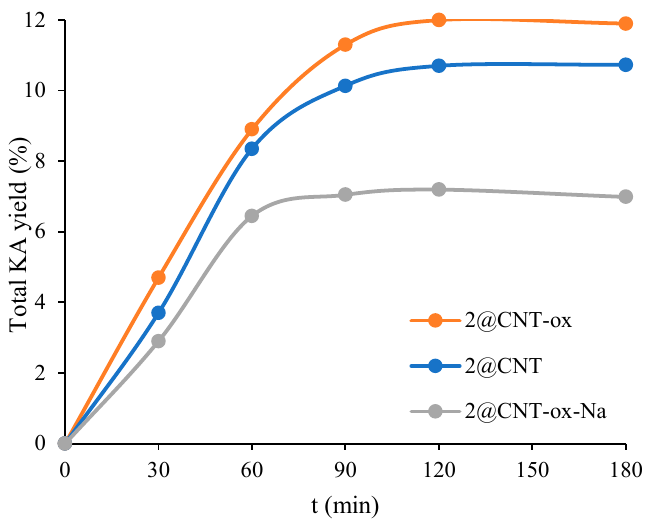
Figure 5. Effect of the duration of the MW irradiation on the catalytic activity of 2@CNT materials for the oxidation of cyclohexane with TBHP in MeCN.